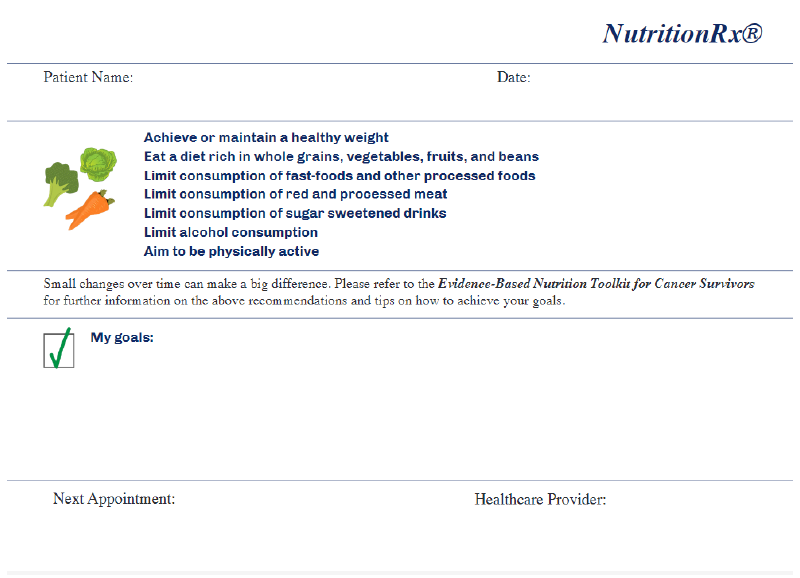
Figure 2. Nutrition Prescription Pad.